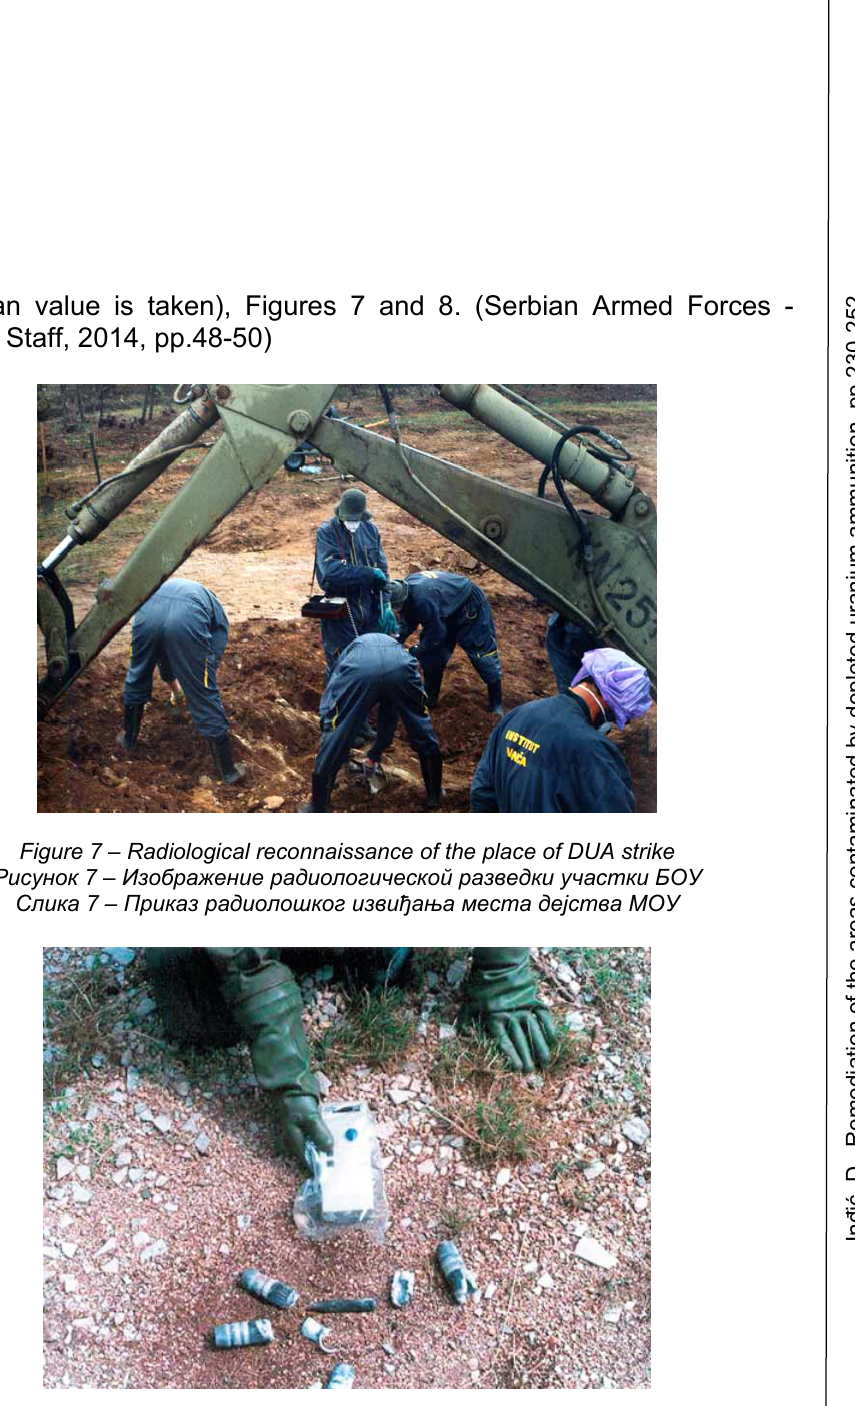
Figure 8 – Measurement of the radioactive contamination of DUA samples on the ground Рисунок 8 – Измерение радиоактивного загрязнения образцов БОУ на почве Слика 8 ‒ Мерење радиоактивне контаминације узорака МОУ на